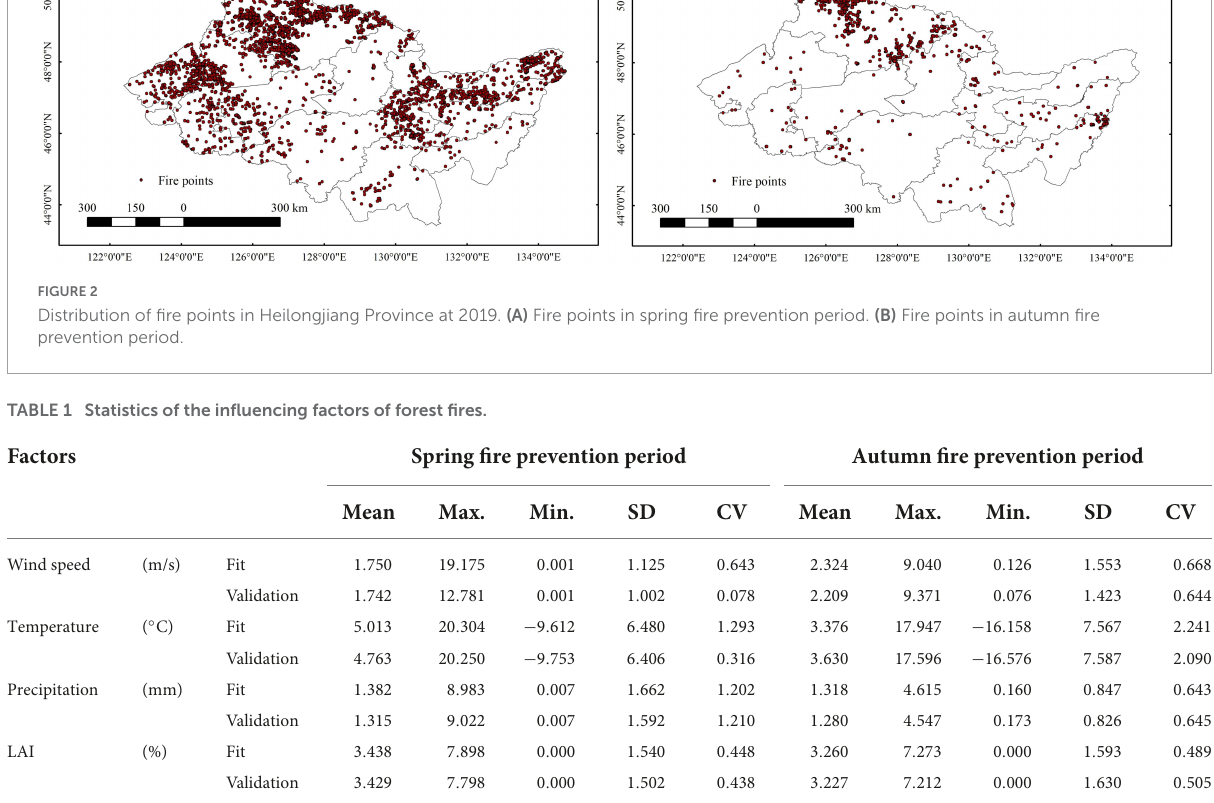
The mixed-effects model is a statistical analysis model composed of fixed effects and random effects. In order to understand the impact of different geographic regions on meteorological conditions and overcome its spatial heterogeneity, we divided the data into 13 groups, corresponding to the 13 prefecture-level cities in Heilongjiang Province ( Figure 1 ). We tested different mixed models that containing random effects on different combinations of parameters based on the LR model to find the optimal parameters that random effects account for. In this way,